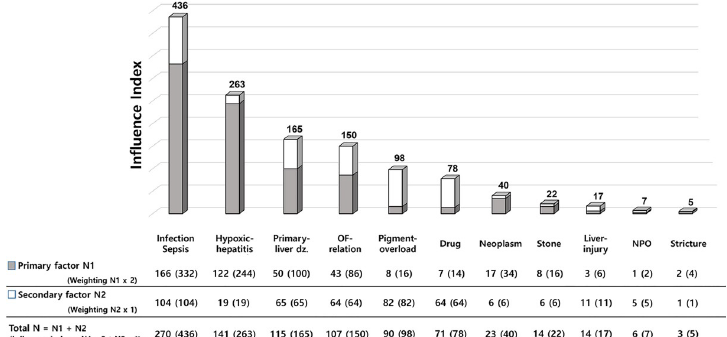
Fig 2. Influence index of main factors causing extreme hyperbilirubinemia (ranked multiple response analysis). Primary factor: the 1 st important cause of extreme hyperbilirubinemia in each patient. N1: the number of factors identified as Primary factor. Secondary factor: the 2 nd important cause of extreme hyperbilirubinemia in each patient. N2: the number of factors identified as Secondary factor. Abbreviation: dz., disease; OF, organ failure; NPO, nil-per-os.